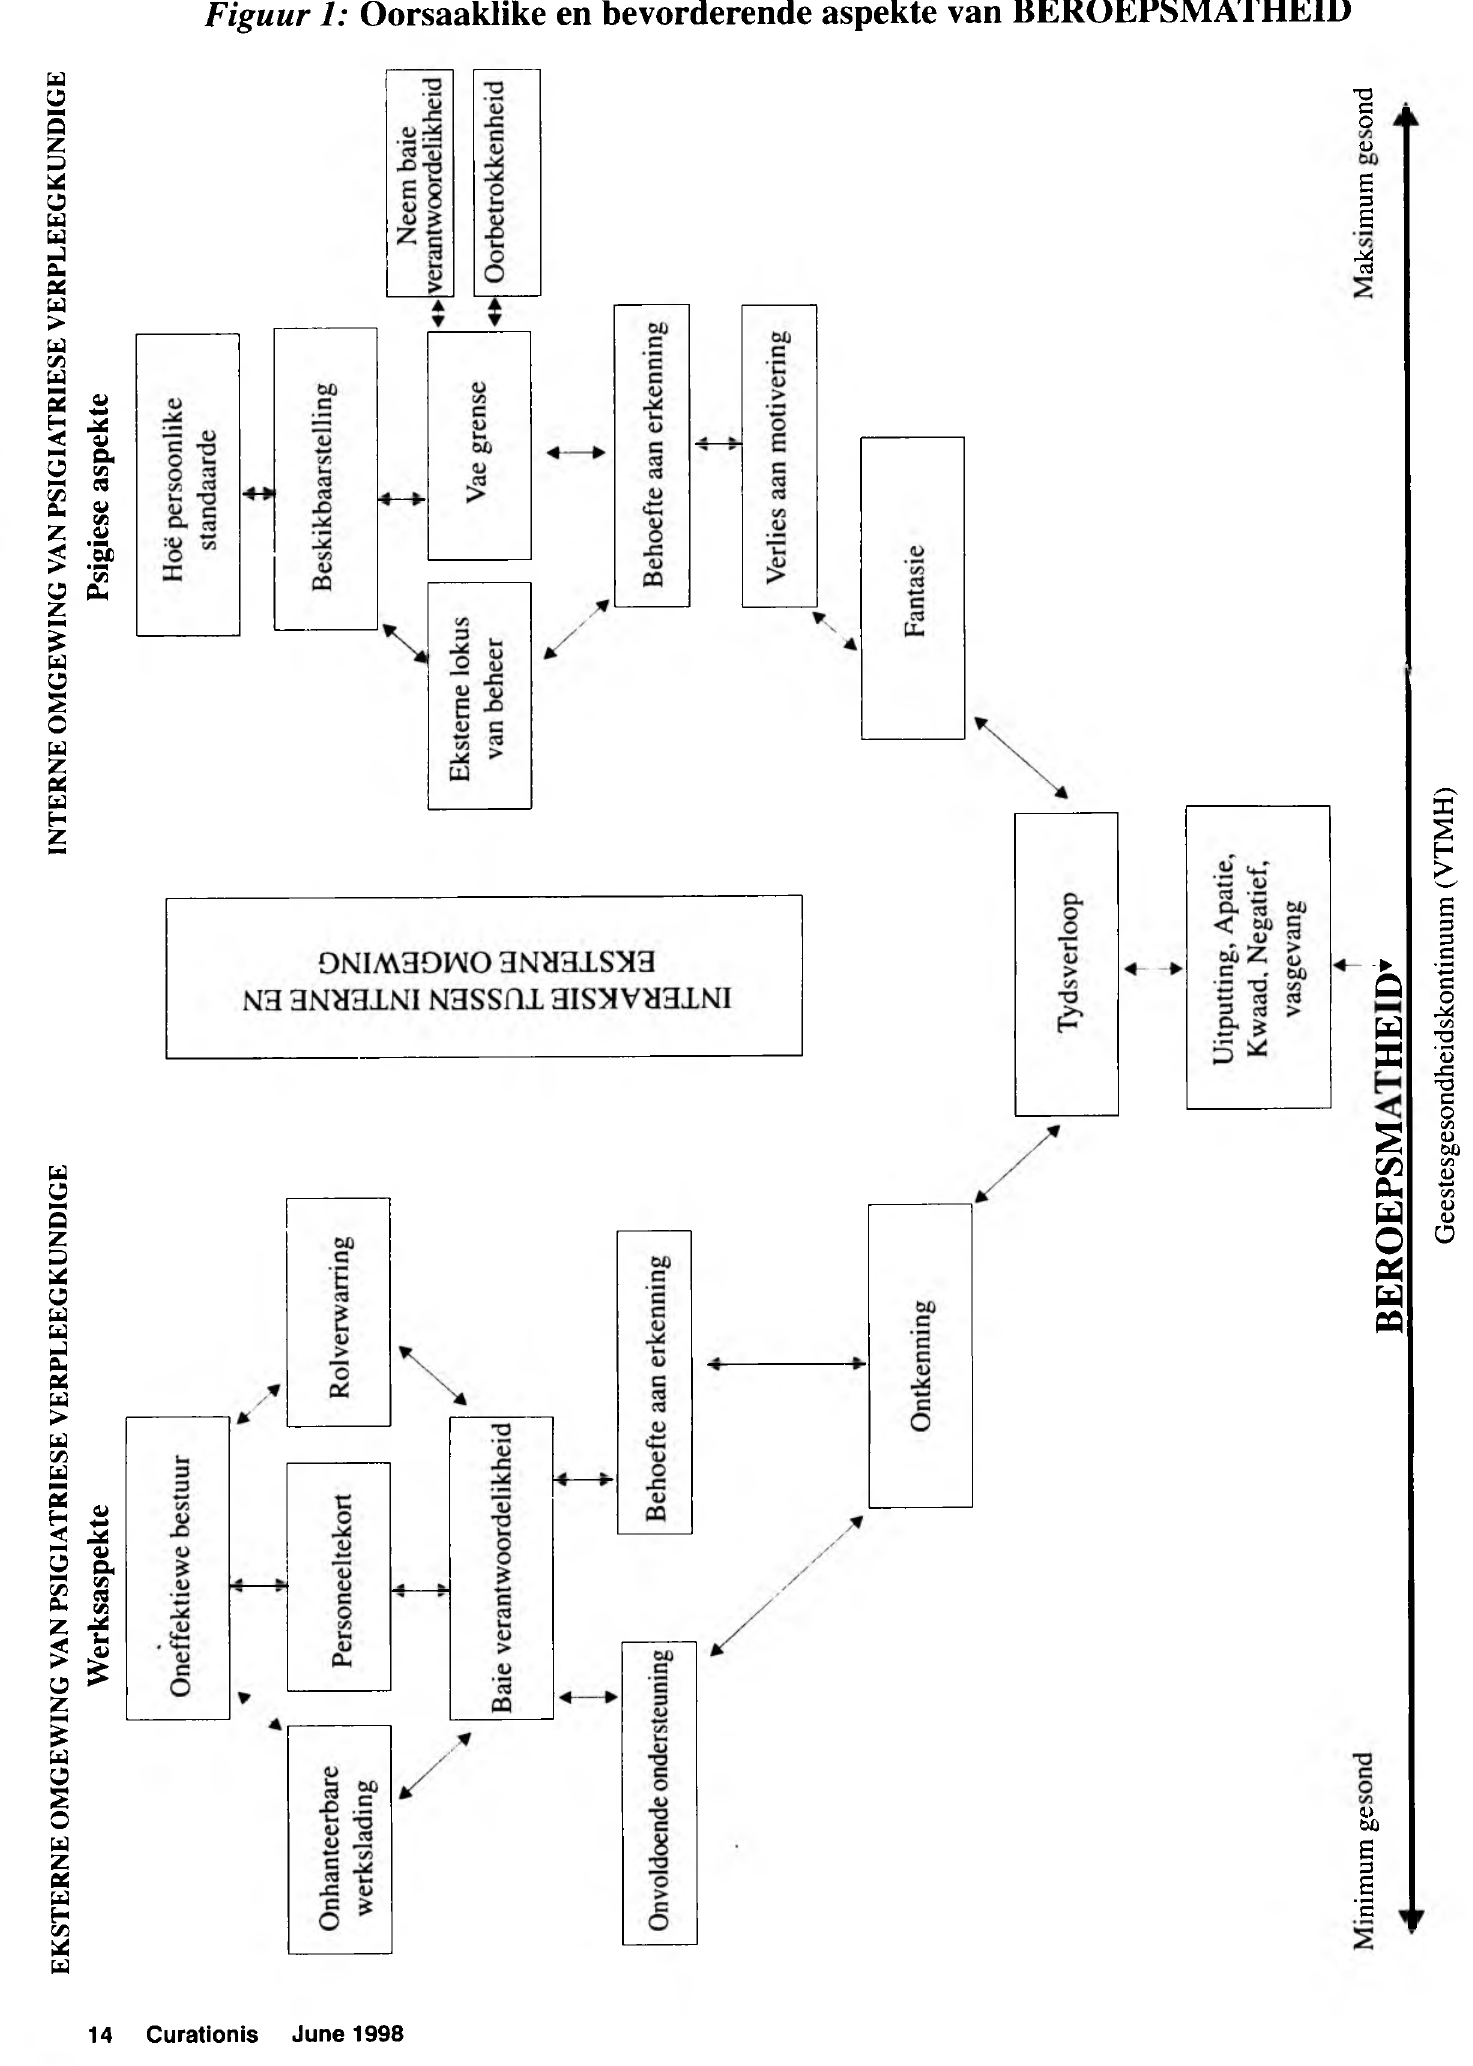
Figuur 1: Oorsaaklike en bevorderende aspekte van BEROEPSMATHEID